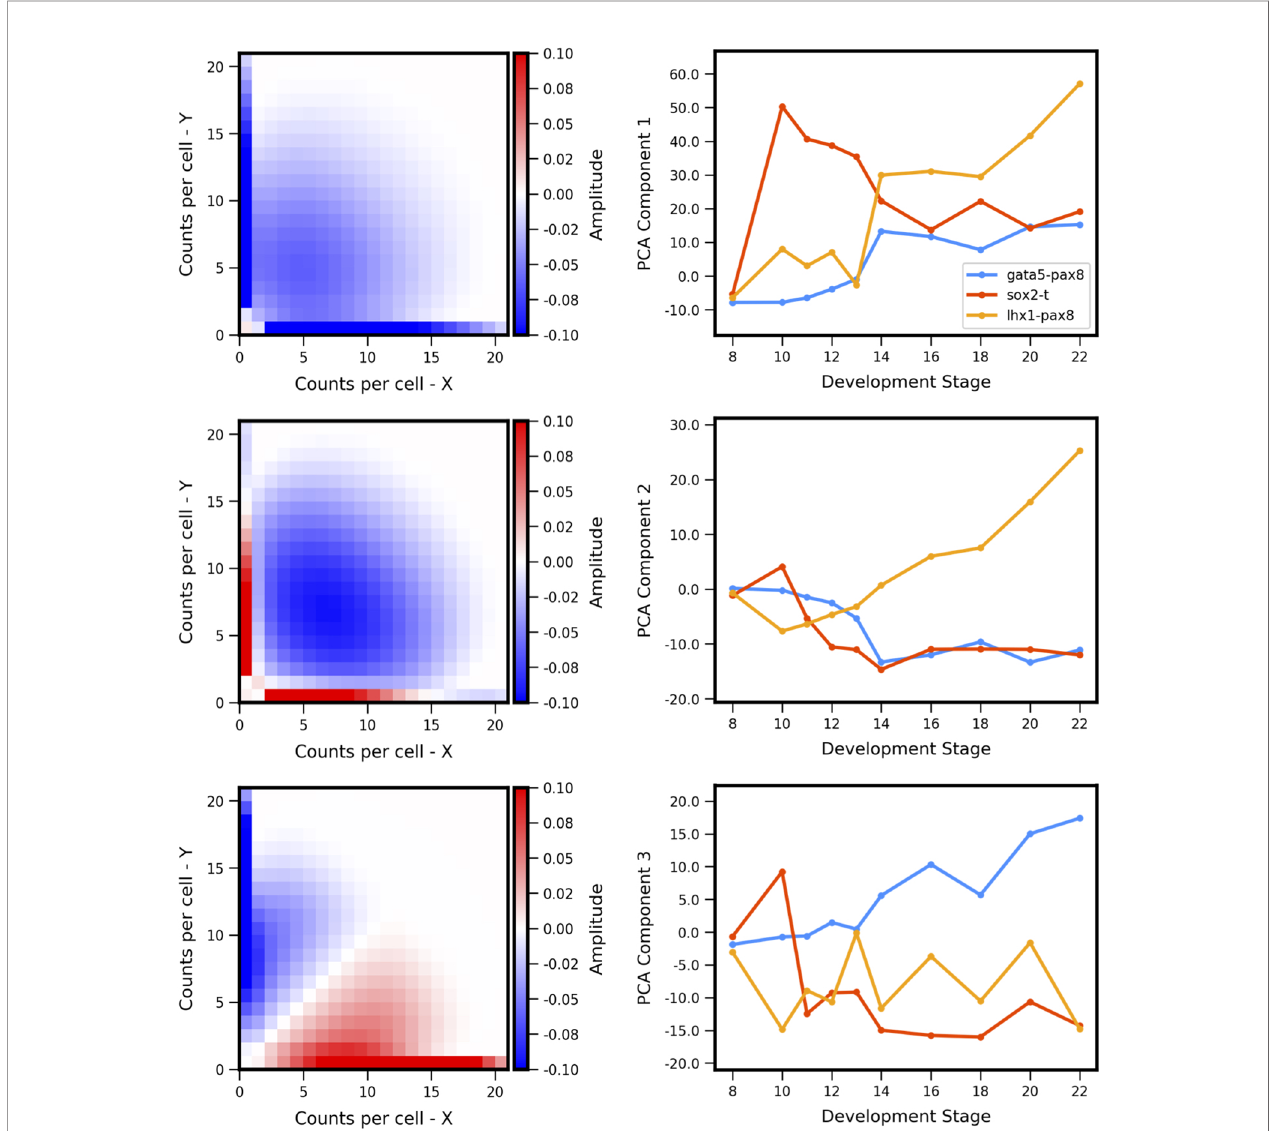
FIGURE 7 | Principal components of landscape shape features. (Left Column) The reshaped Principal Component Analysis (PCA) principal axes in feature space which represent the maximum variance in the data, speci fi cally which features of the coexpression landscape that each component is accounting for. (Right Column) Magnitude or positive/negative value shift in observed variance for the respective component for each gene pair, versus developmental stage. Each component summarizes a landscape shape features: (Top Row) The overall amount of gene expression, (Middle Row) Antagonistic Expression vs. Coexpression of the two genes, and (Bottom Row) degree of asymmetric expression between the two